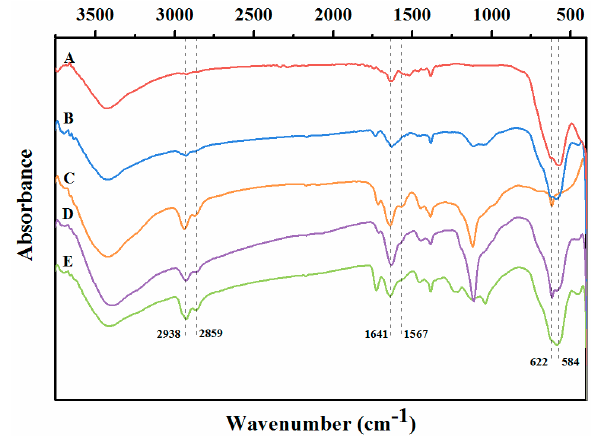
Figure 3. The FT-IR spectrum of ( A ) Fe 3 O 4 nanoparticles; ( B ) (3-aminopropyl)triethoxysilane (APTES)- functionalized Fe 3 O 4 nanoparticles; ( C ) RML CLEAs; ( D ) magnetic RML CLEAs; ( E ) AOT-activated magnetic RML CLEAs. (Sodium bis-2-(ethylhexyl) sulfosuccinate, AOT).